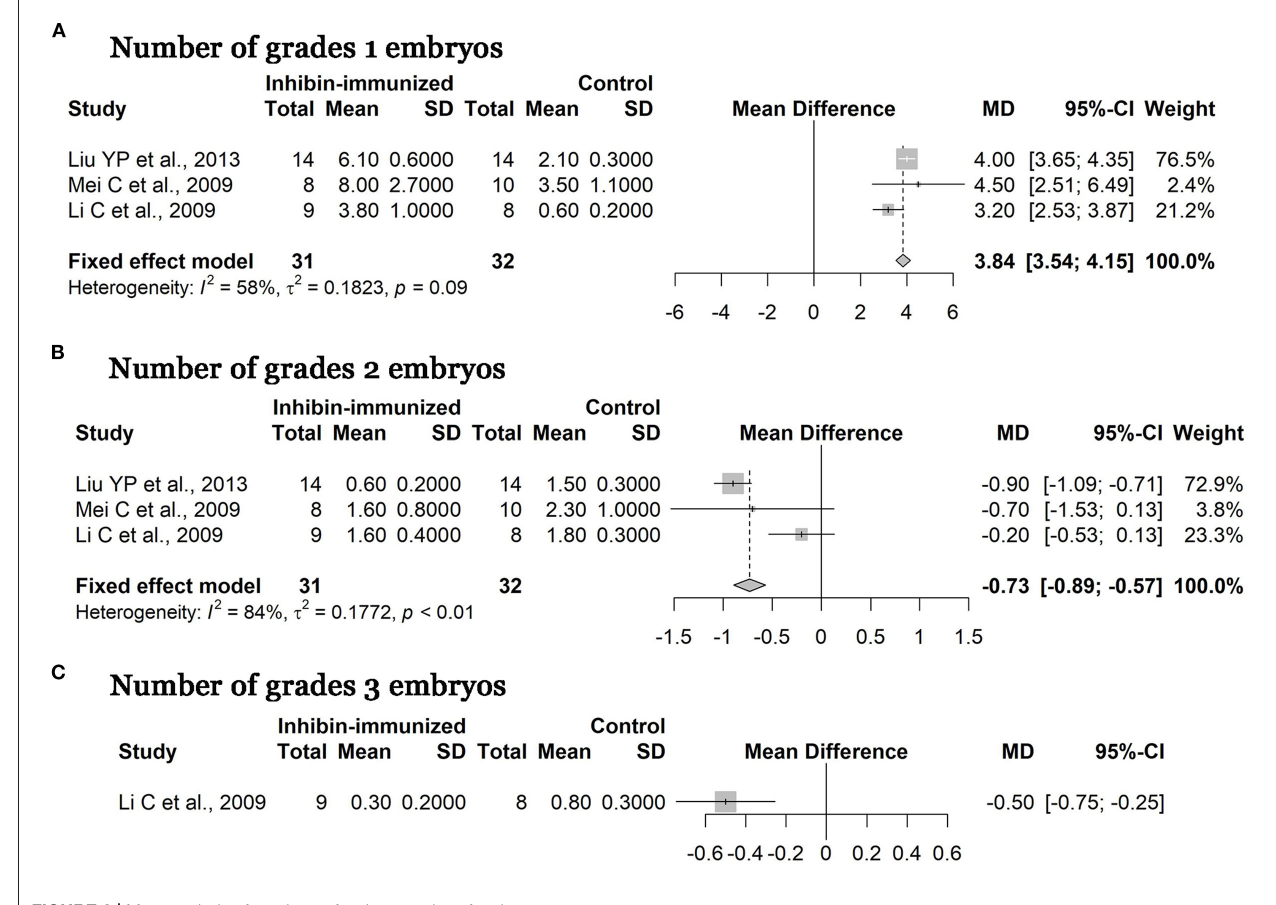
FIGURE 6 | Meta-analysis of numbers of various grades of